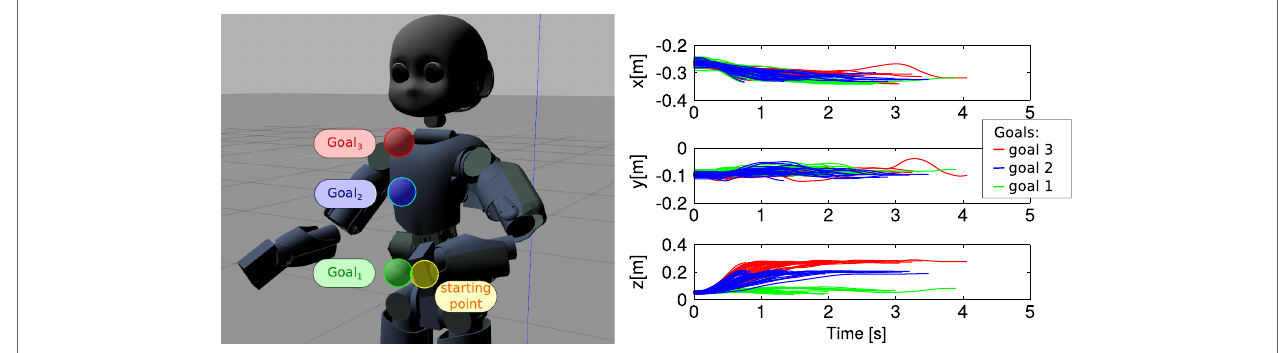
FIGURE 7 | Left: the three colored targets that the robot must reach from the starting point; the corresponding trajectories are used to learn three primitives representing three skills. Right: the Cartesian position information of the demonstrated trajectories for the three reaching tasks.